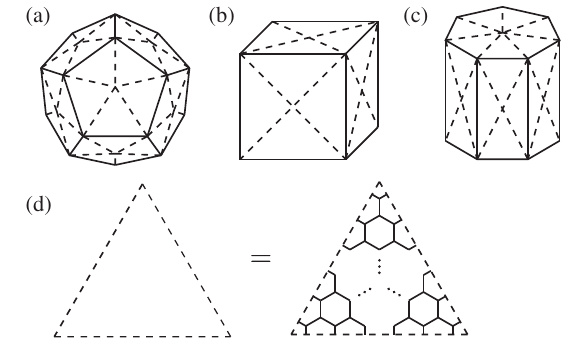
FIG. 7. Quantization of the disclination charge. (a) Twelve pentagon disclinations on a sphere in the shape of a dodecahe- dron, e.g., the buckyball. (b) Six square disclinations on a sphere in the shape of a cube. (c) Two N -gons and N squares on a sphere in the shape of a cylinder. (d) Each of the small triangles in the above three examples contains many plaquettes. The triangle vertices coincide with plaquette centers and the triangle edges are perpendicular to plaquette edges. In (a) – (c), disclinations are all located at face centers, and all corners are regular since there are six surrounding